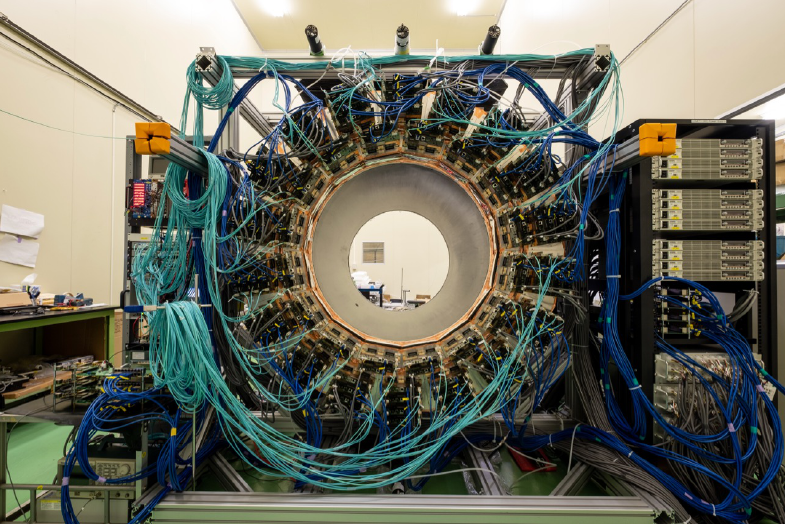
Figure 9. Photograph of the CDC being tested with cosmic